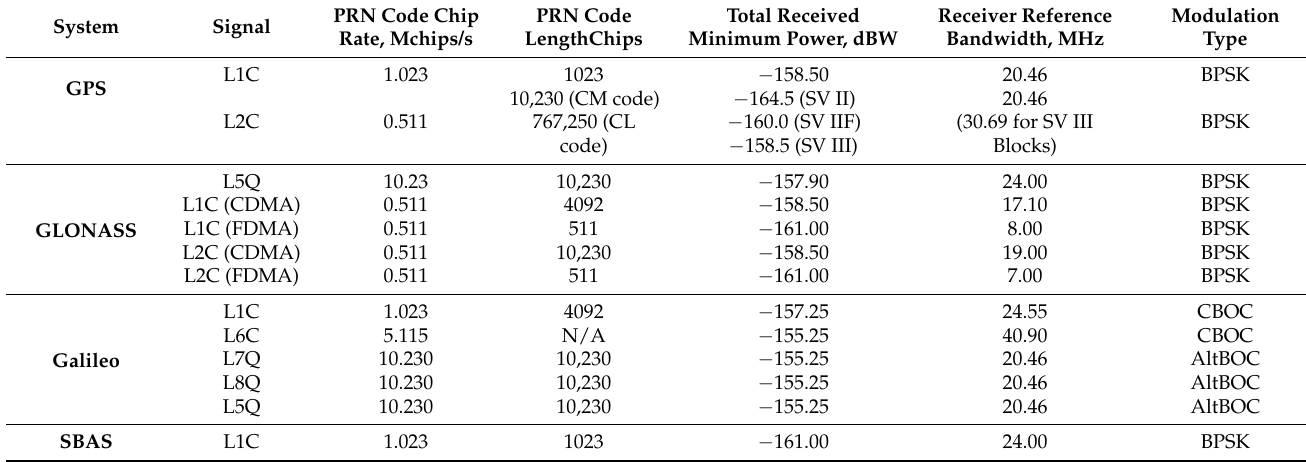
Table 1. The GNSS signals and range codes